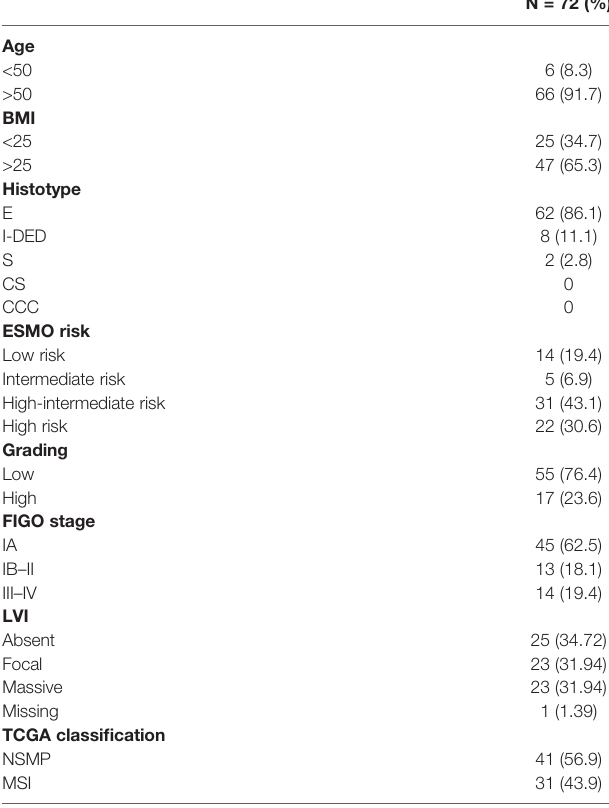
TABLE 1 | Characteristics of the study